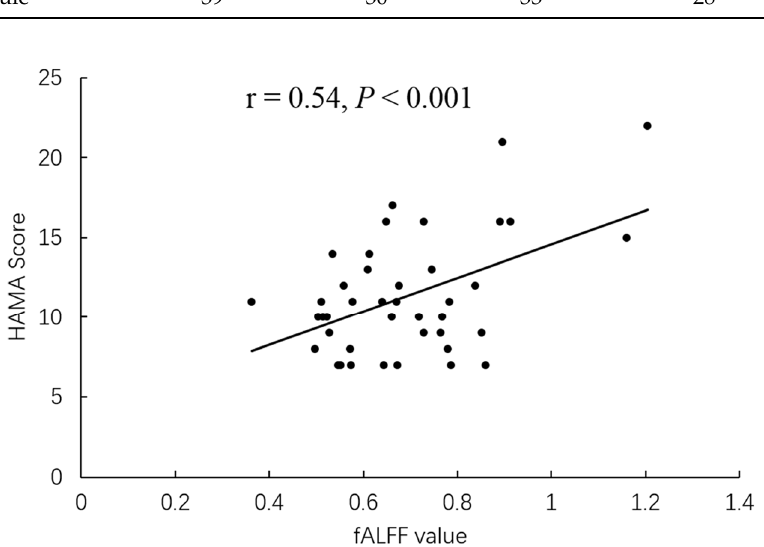
Figure 2. Brain regions showing differences in fALFF between groups. The red region represents the brain region with significantly increased fALFF (PD ‐ A > HC, PD ‐ A > PD ‐ NA, and PD ‐ NA > HC), and the blue region represents the brain region with significantly decreased DC (PD ‐ A < HC, PD ‐ A < PD ‐ NA, and PD ‐ NA < HC).